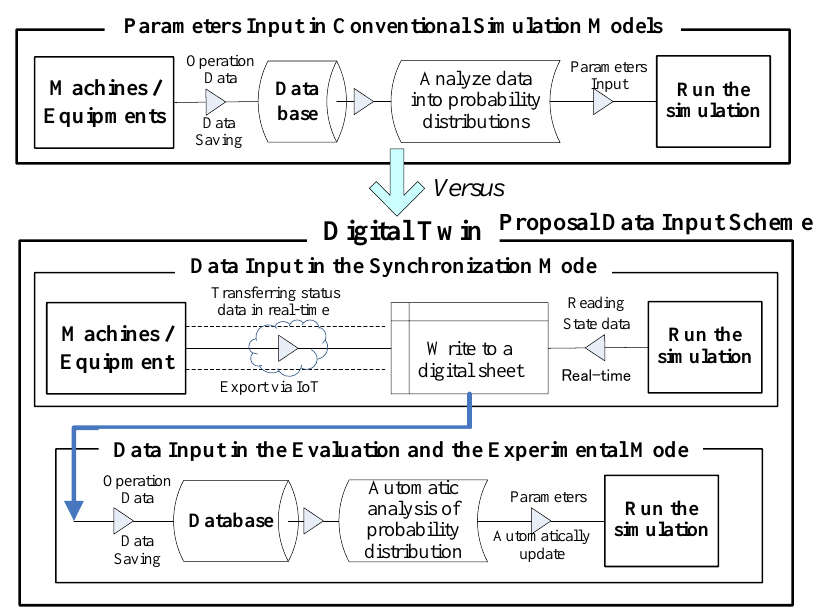
Figure 4. Proposal of data input scheme for simulation models in a DT.